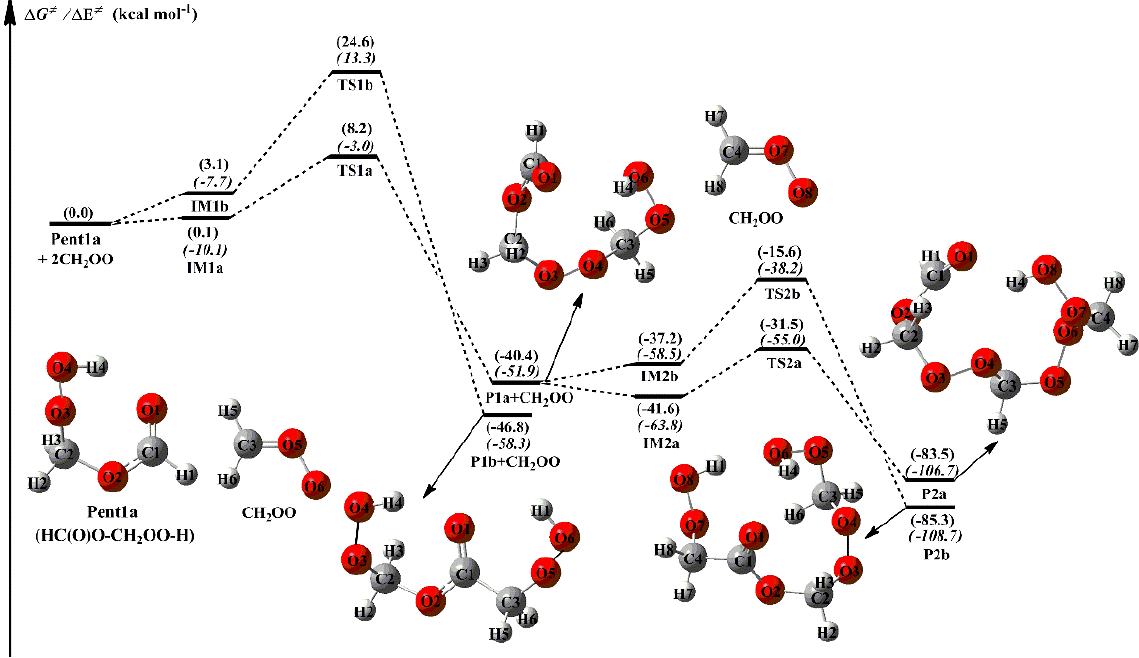
Figure 2. PES ( (cid:49)G and (cid:49)E ) for the 2CH 2 OO + Pent1a reaction at the M06-2X/ma-TZVP//M06-2X/6-311 + G(2df,2p) level of theory.